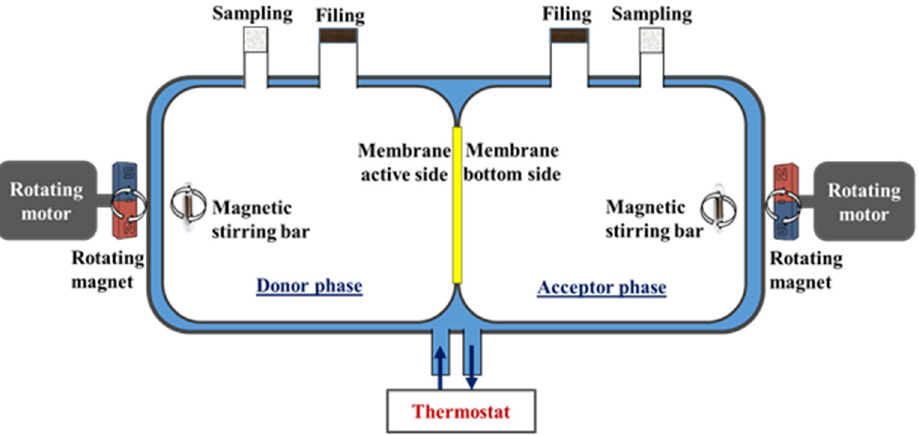
Figure 2. Scheme of the experimental pertraction set-up.